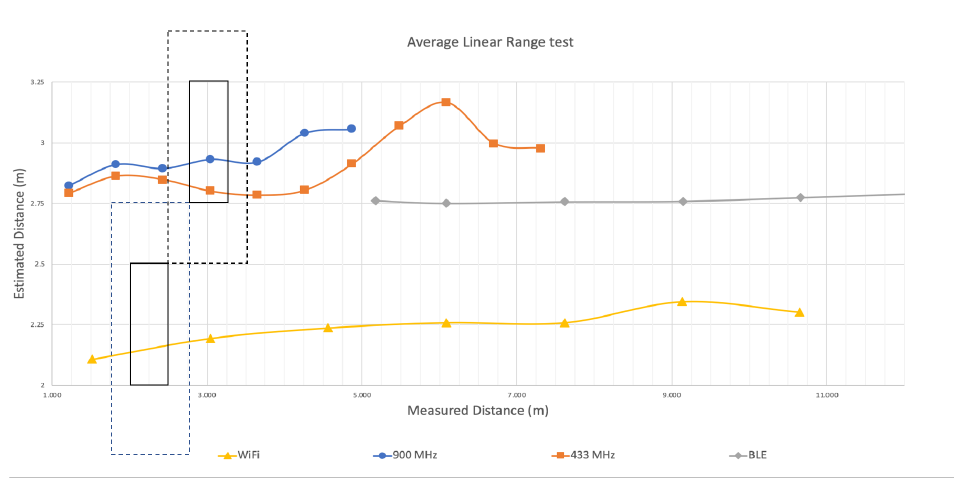
Figure 5. Estimated distance relative to measured distance between two devices using BLE, 433 MHz, 915 MHz, and Wi-Fi transceivers. Ideally, the estimated distances would scale proportionally with measured distances for each of the transceivers used. However, these results show that distance estimation using these transceivers with lateration techniques that require multiple ranges will lead to significant position accuracy